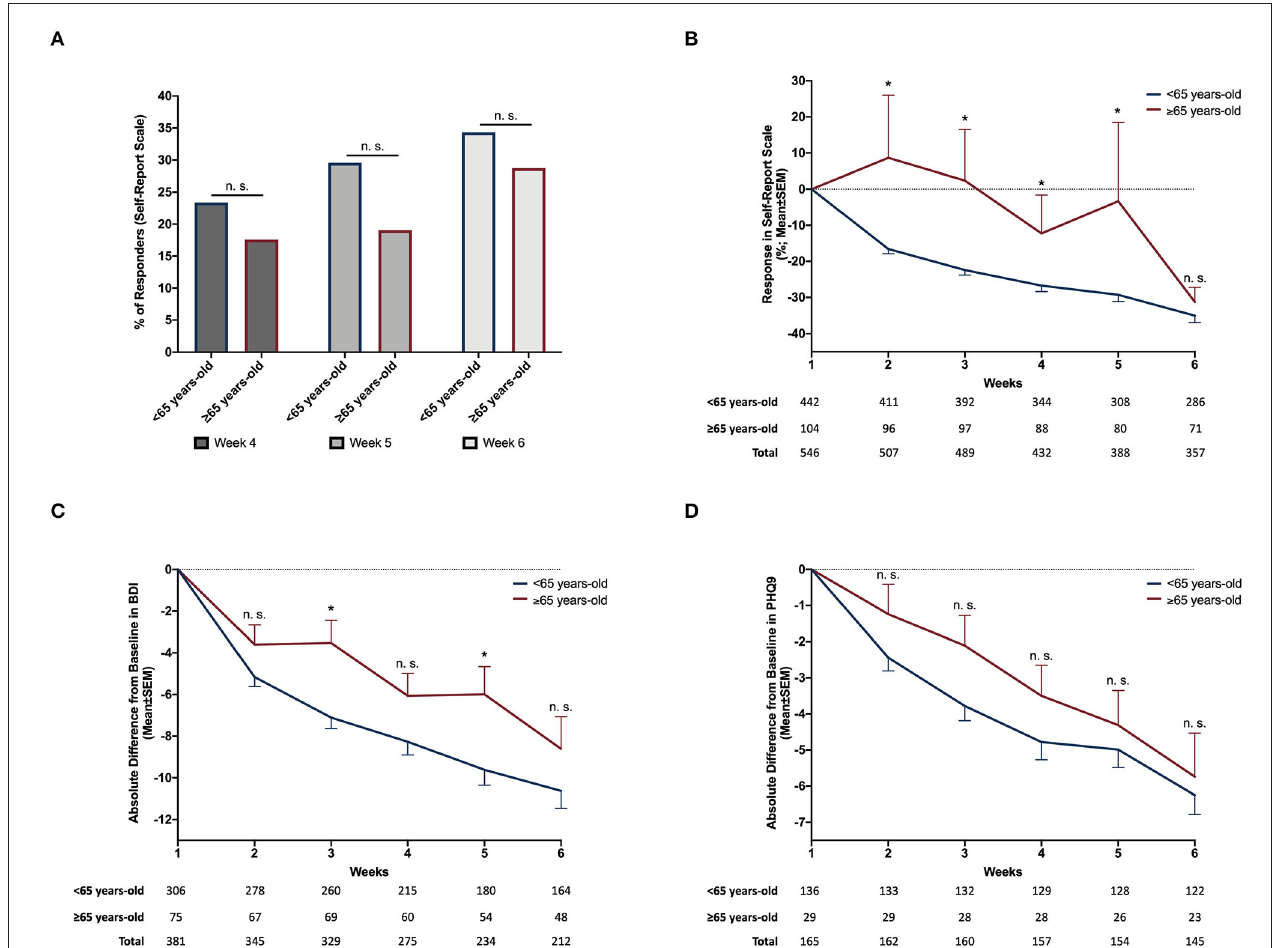
FIGURE 1 | Differences in antidepressant response across rTMS treatment between < 65 and ≥ 65 years-old patients. When comparing the percentage of responders between < 65 years-old and ≥ 65 years-old group using a chi-squared test, no differences were observed in any of the tested time points: 4th week − 23.4 vs. 17.6%, p = 0.2|5th week − 29.6 vs. 19.1%, p = 0.06|6th week − 34.3% vs. 28.8%, p = 0.3 (A) . When analyzed using longitudinal mixed effects regression model, % change of depression severity in self-report scale was found to decrease across time (ß = − 7.8 ± 0.8, p < 0.0001). No differences were observed between the two age groups (ß = 2.8 ± 3.6, p = 0.4) but we found a significant interaction between time and age group (ß = 5.5 ± 1.9, p = 0.003). Post-hoc t -tests revealed larger decreases of depression severity in < 65-years-old when compared to ≥ 65 years-old until week 5 (B) . When considering absolute difference of BDI scores relative to baseline (week 1), we also observed that depression severity decreased across time (ß = − 2.8 ± 0.2, p < 0.0001) as well as a significant effect of age group (ß = − 1.3 ± 0.6, p < 0.04) and interaction (ß = 1.4 ± 0.4, p < 0.0001). Post-hoc t -tests revealed larger decrease of depression severity in < 65-years-old only in week 3 and 5 (C) . When considering absolute difference of PHQ9 scores from baseline (week 1), there was a significant effect of time (ß = − 1.1 ± 0.1, p < 0.0001), but no effect of age group (ß = 0.8 ± 0.5, p < 0.1) or interaction (ß = 0.002 ± 0.2, p < 1.0). No differences were found in post-hoc comparisons between the two